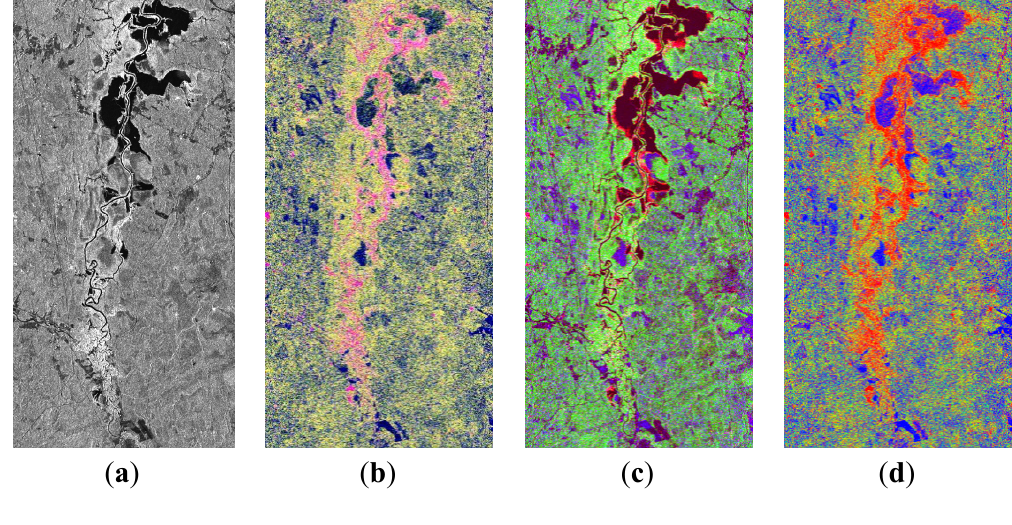
Figure 2. Quicklooks for different polarimetric decompositions of the first image dating from 27 April 2010. ( a ) Total intensity equal to Kennaugh K Mean Alpha, Entropy, Anisotropy; ( c ) Freeman-Durden RGB: Double-bounce,